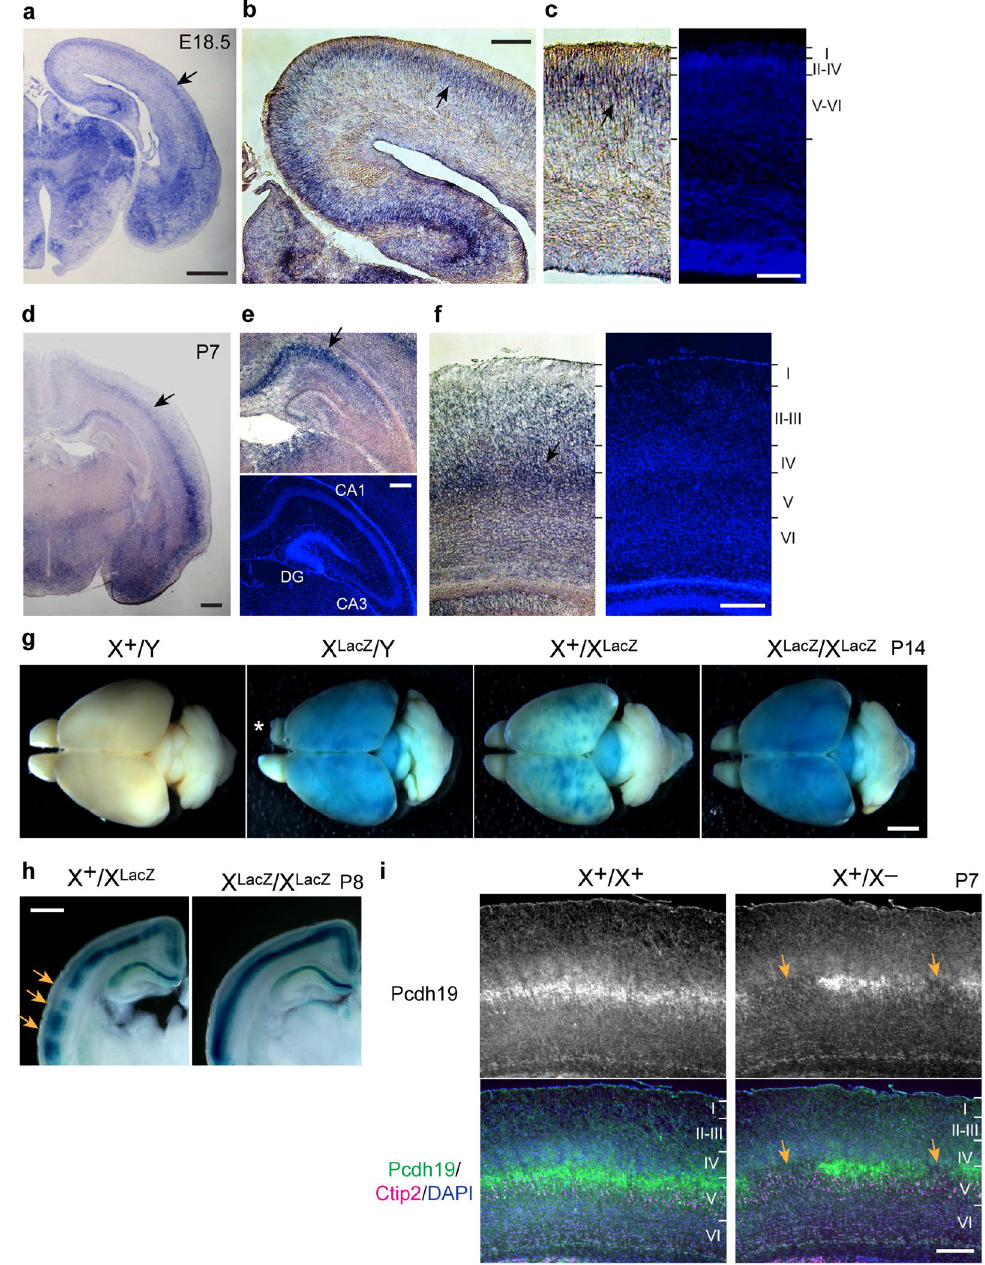
Figure 1. Pcdh19 expression in the cerebral cortex and hippocampus becomes patchy in heterozygous female mutants. ( a – c ) In situ hybridization of Pcdh19 mRNA in E18.5 brain. Signals were detected in the cerebral cortex and thalamus ( a ). Pcdh19 mRNA showed a continuous distribution in the cortex and hippocampal CA1 region ( b ). Pcdh19 mRNA localized mainly in the upper part of the deep layer (layer V) ( c ). ( d – f ) In situ hybridization of Pcdh19 mRNA in P7 brain. Pcdh19 expression was detected in the cortex and hippocampal region ( d ). Higher magnification images show that Pcdh19 localized in the hippocampal CA1 ( e ) and cortical layer V ( f ). ( g ) X-gal staining of whole brains from P14 mice to detect the activity of LacZ that was knocked-in to the Pcdh19 gene locus. Note that the distribution of X-gal signals becomes patchy in Pcdh19 heterozygous female mutants (X + X LacZ ), whereas the signals were evenly detected in the whole cortical region in hemizygous male (X LacZ Y) and homozygous female mutants (X LacZ X LacZ ). Wild-type male (X + Y) brain was used as a negative control. Asterisk in the image of X LacZ Y indicates dissection artifacts. ( h ) Coronal slices of brain from heterozygous (X + X LacZ ) and homozygous (X LacZ X LacZ ) female mice at P8 after X-gal staining. Arrows indicate X-gal-negative regions in the heterozygous mutant brain. ( i ) Localization of Pcdh19 (green), Ctip2 (magenta) and DAPI (blue) in layer Va in the somatosensory cortex of wild-type (X + X + ) and Pcdh19 heterozygous (X + X − ) female mice at P7. Arrows indicate a Pcdh19-negative region in the heterozygous mutant brain. We used 14- μ m-thick ( a – f ) and 10- μ m-thick ( i ) sections. Scale bars, 2 mm in ( g ) 1 mm in ( a , d , h ) 200 μ m in ( b , c , e , f ) 100 μ m in ( i